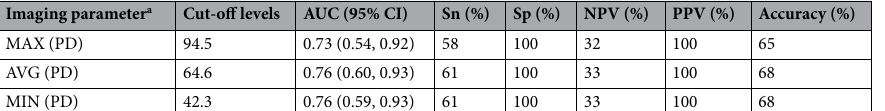
ROC analysis. The area under the ROC curves (AUCs) (95%CI) using optimal cut-off levels of ≥ 94.5, ≥ 64.6 and ≥ 42.3 in identifying patients with DAS28 > 3.2 were 0.73 (0.54, 0.92), 0.76 (0.60, 0.93) and 0.76 (0.59, 0.93) for MAX (PD), AVG (PD) and MIN (PD), respectively (see Table 2) with sensitivity ranging from 58 to 61% and specificity all 100% (the specific sensitivity, specificity, negative predictive value, positive predictive value and accuracy results for the CTUS imaging parameters are summarized in Table 2).